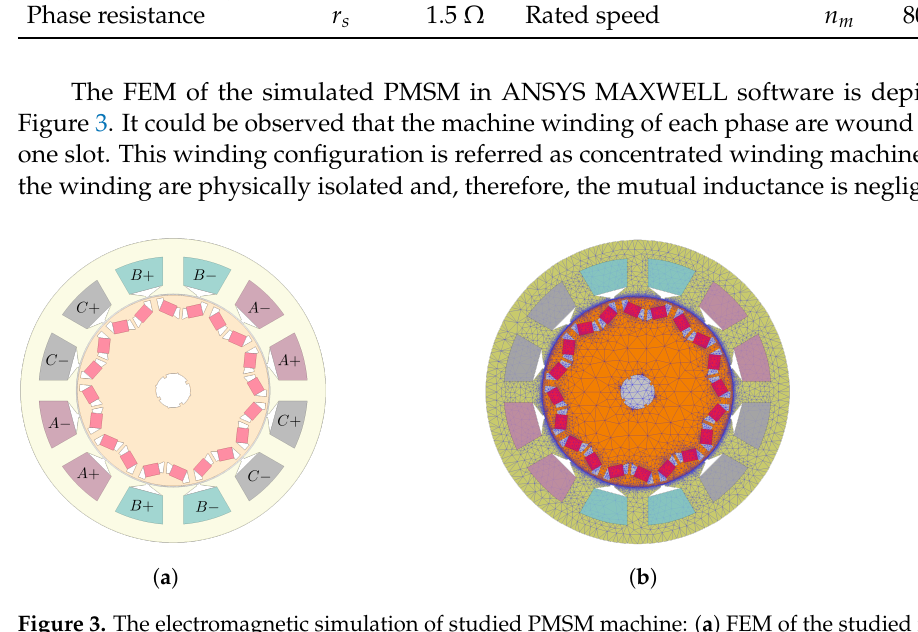
Figure 3. The electromagnetic simulation of studied PMSM machine: ( a ) FEM of the studied machine and ( b ) Mesh of the machine